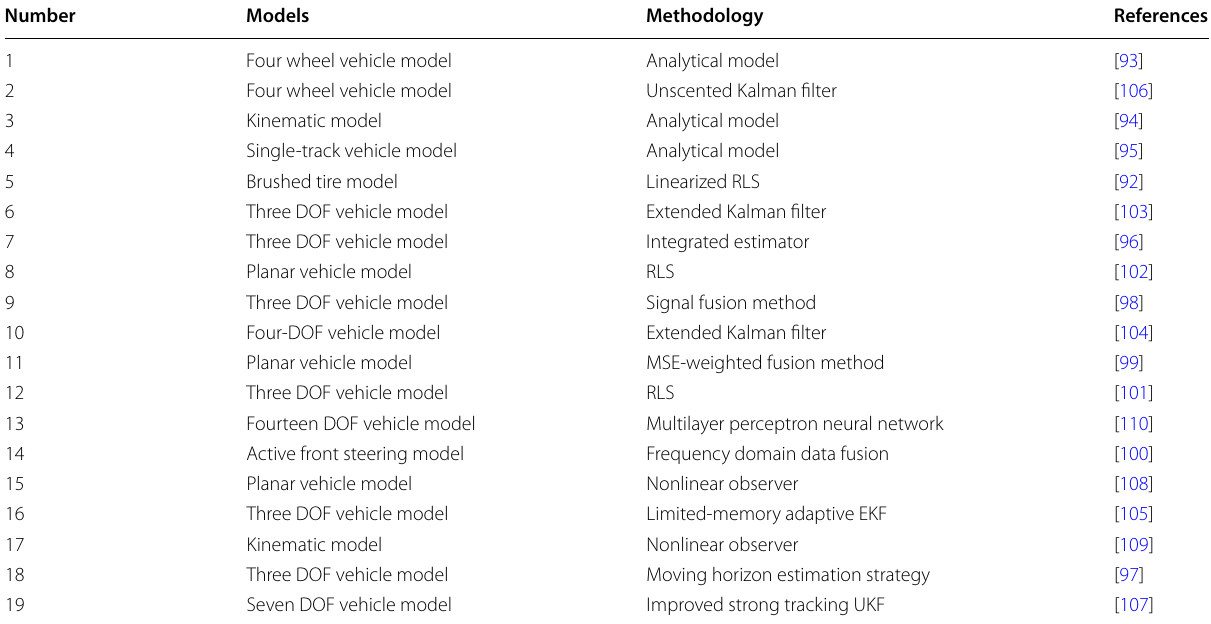
Table 3 Summary of estimation methods based on vehicle coupled dynamics Number Models